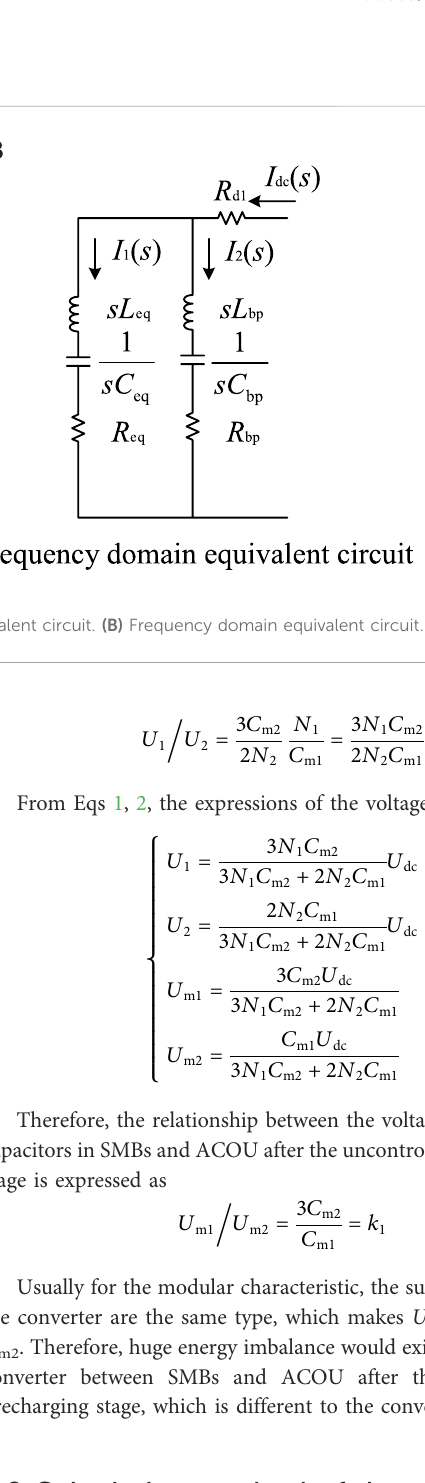
Figure 5A. L m and R m are the inductance and inner resistance of the arm inductor. C bp is the tuned fi lter capacitor. L bp and R bp are the inductance and inner resistance of the tuned fi lter inductor.